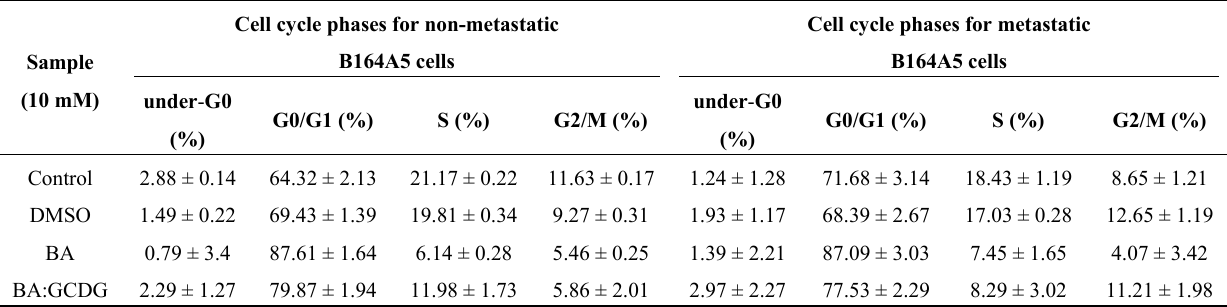
Table 1. Evaluation of cell cycle phases variation between control, B164A5 and B164A5 metastatic melanoma cells treated with GCDG, BA and their 1:1 complex.